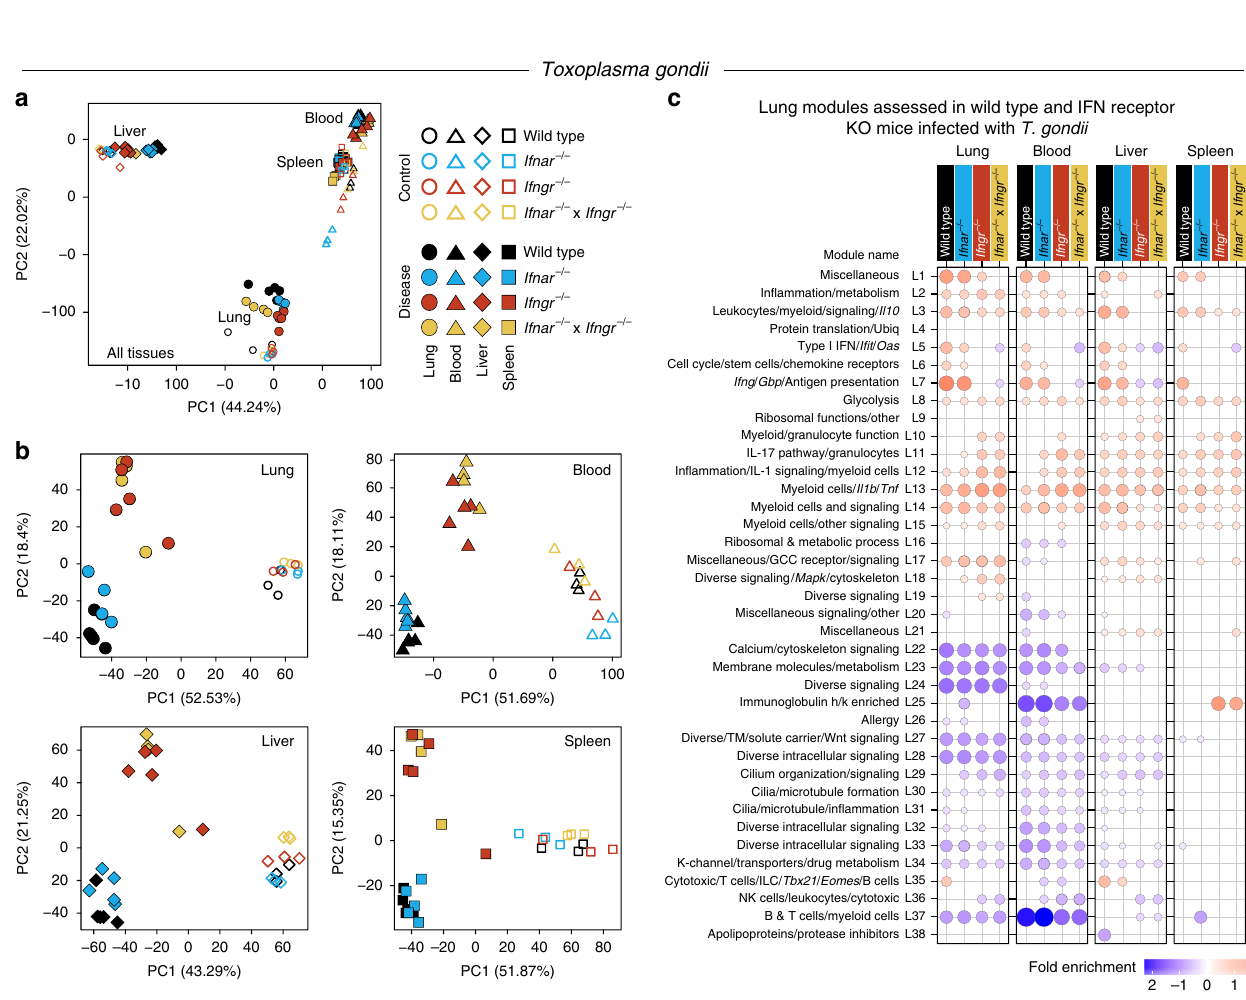
Fig. 5 Changes in the transcriptional pro fi les across tissues following T. gondii infection, in the absence of Type I and/or II IFN signaling. a , b Principal component analysis across all tissues — lung, blood, liver, and spleen ( a ), and individually in each tissue ( b ), depicting the variation in the global gene expression pro fi les across tissue type, disease, and host genotype. Principal components 1 (PC1) and 2 (PC2), which describe the greatest variation in gene expression, are shown. Shape represents the different tissues, empty and fi lled symbols represent control and disease samples, respectively, and color represents host genotype: Wild type, Ifnar − / − , Ifngr − / − and double Ifnar − / − × Ifngr − / − mice. c Modular transcriptional pro fi les of all tissues assessed using the lung modules in Wild type and IFN receptor knockout (KO) mice after infection. Red and blue circles indicate the cumulative over- or under-abundance of all genes within the module for each Wild type and IFN receptor KO disease group compared to the respective Wild type controls in each tissue. Color intensity of the dots represents the degree of perturbation, indicated by the color scale. Size of the dots represents the relative degree of perturbation, with the largest dot representing the highest degree of perturbation within the plot. Within each group, only modules with FDR p -value < 0.05 were considered signi fi cant and depicted here. GCC glucocorticoid, K-channel potassium channel, TM transmembrane, Ubiq